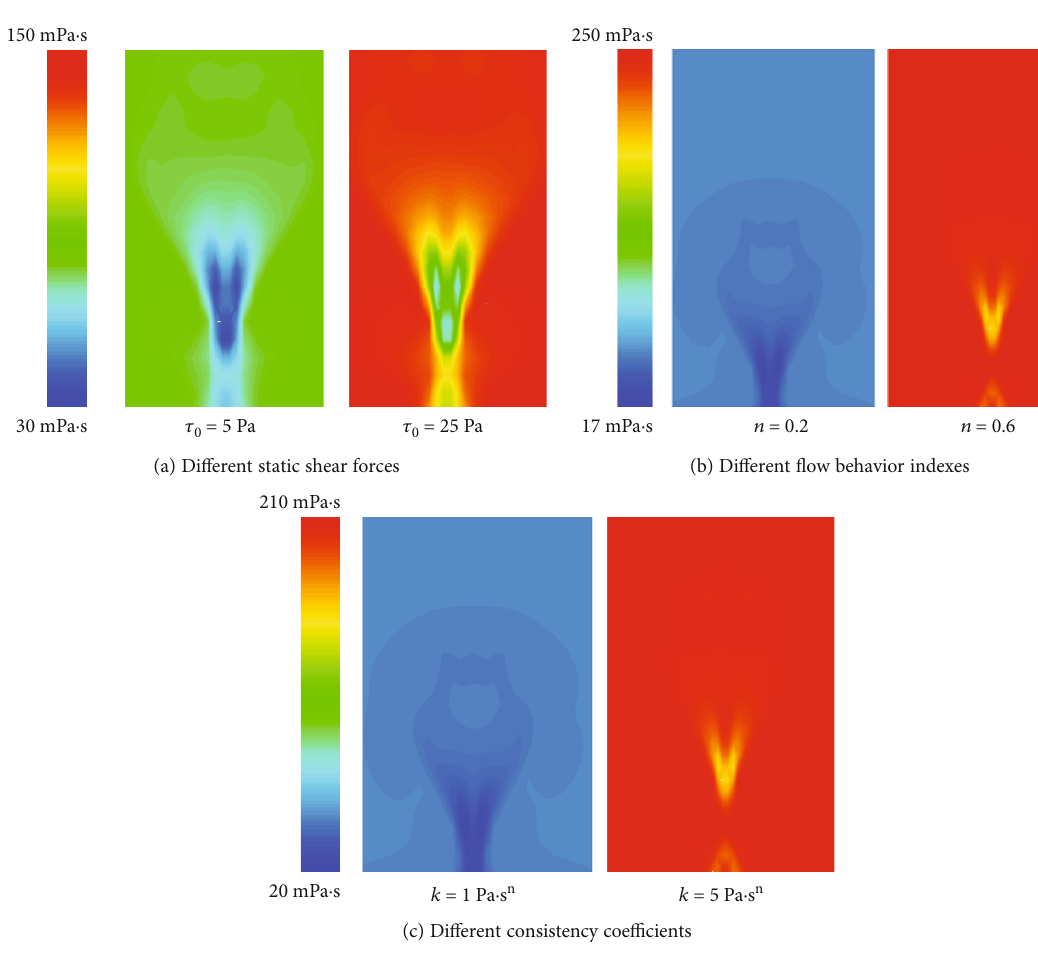
Figure 11: Apparent viscosity of a fl uid at the bubble escape time for di ff erent rheological parameters. Table 6: Dimensionless analysis results of bubble